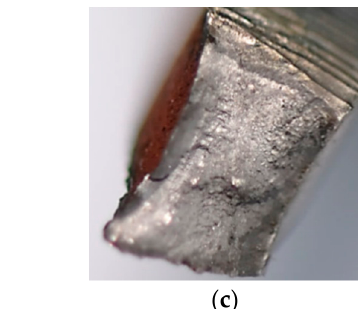
Figure 7. Hardox 450 MAG weld at the final stage of the tensile test: ( a ) General view, ( b , c ) fracture region, and ( d ) the specimen out of the testing machine.